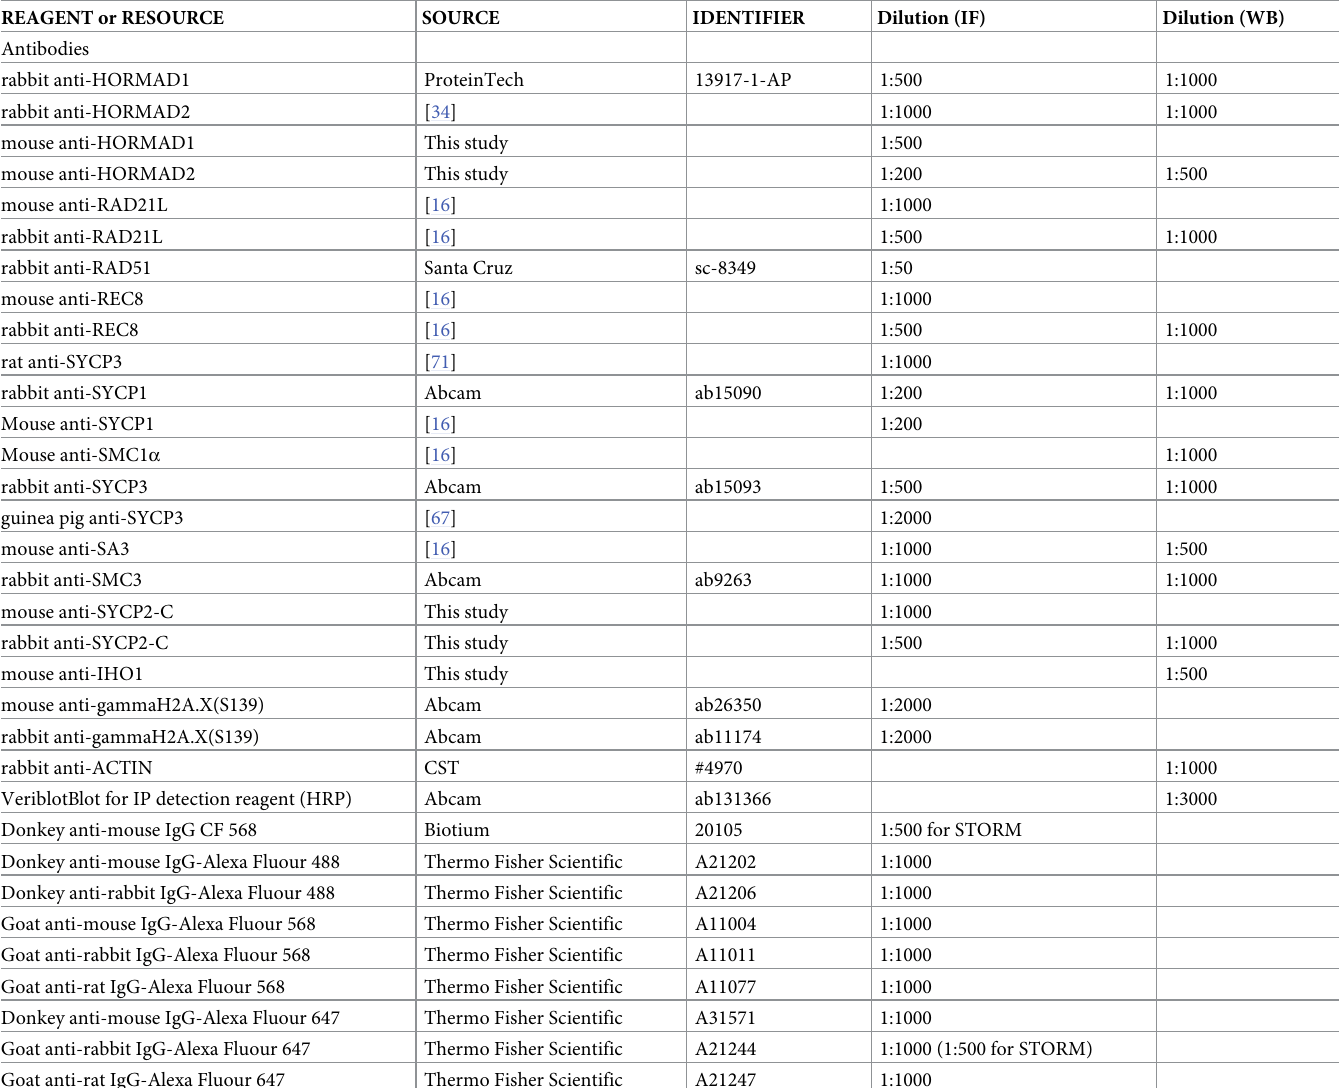
Table 1. Antibodies